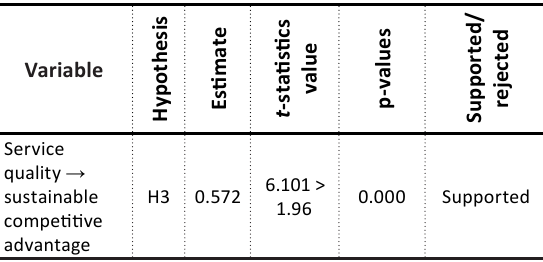
Table 3. Path coefficient for service quality